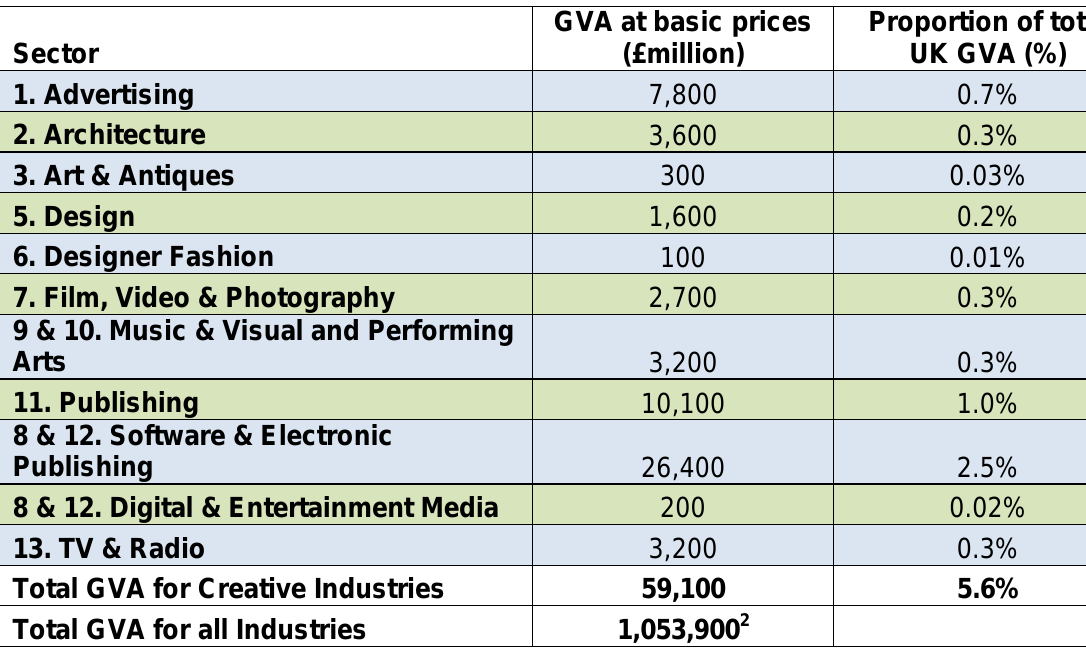
Table 1: Gross Value Added (GVA) of the Creative Industries,